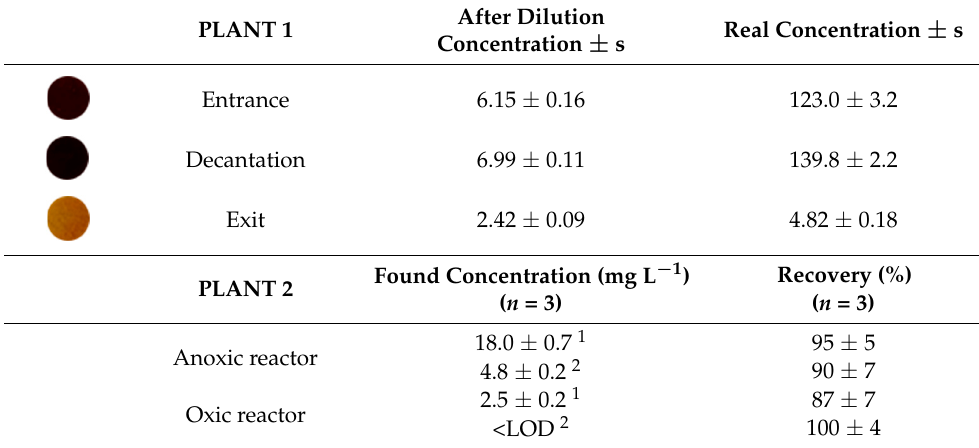
Table 3. Colorimetric sensor response and found concentration from the entrance, decantation, and exit stages from water treatment plant 1 and anoxic and oxic reactors from water treatment plant 2. Sensor images from the different stages of a water treatment plant.